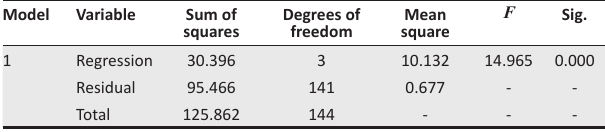
TABLE 4: Analysis of variance of multiple regression.